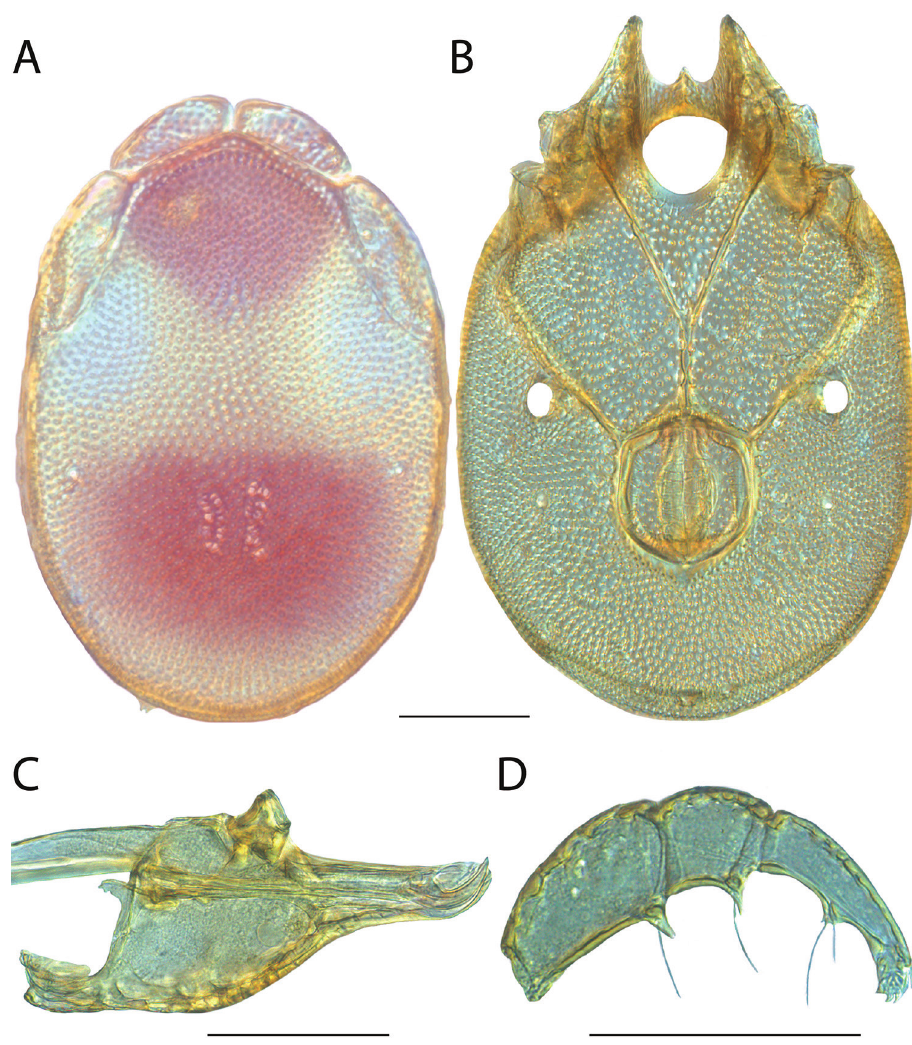
Figure 52. Torrenticola delicatexa male: A dorsal plates B venter (legs removed) C subcapitulum D pe- dipalp (setae not accurately depicted). Scale = 100